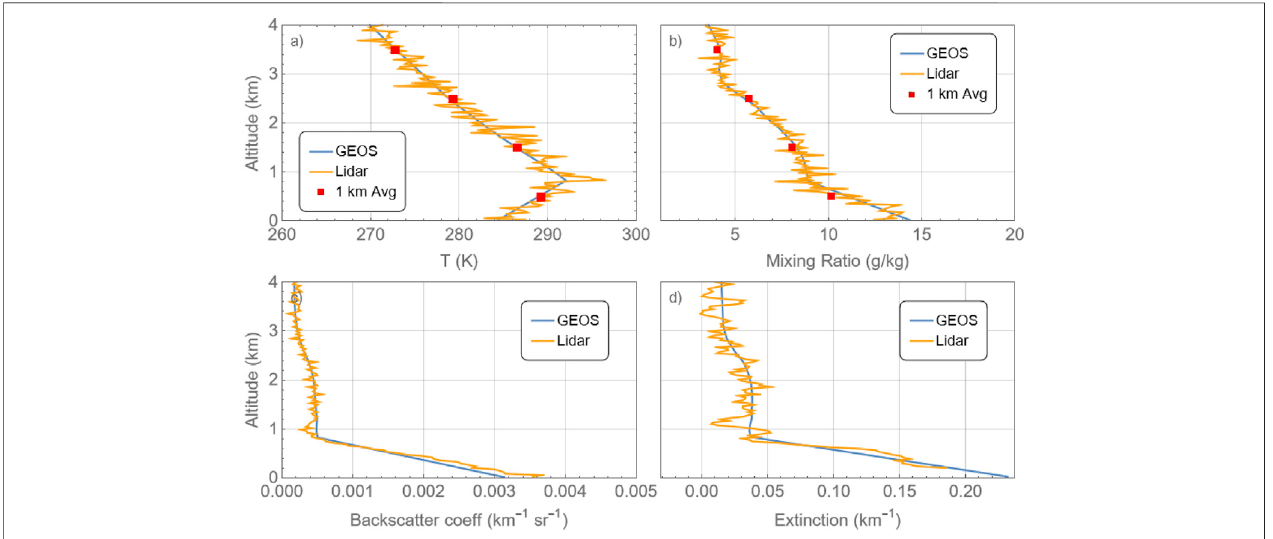
Table 1 . The aerosol backscatter and extinction pro fi les are displayed with the 30 m and 250 m vertical resolutions, respectively, that are indicated in Table 1 .